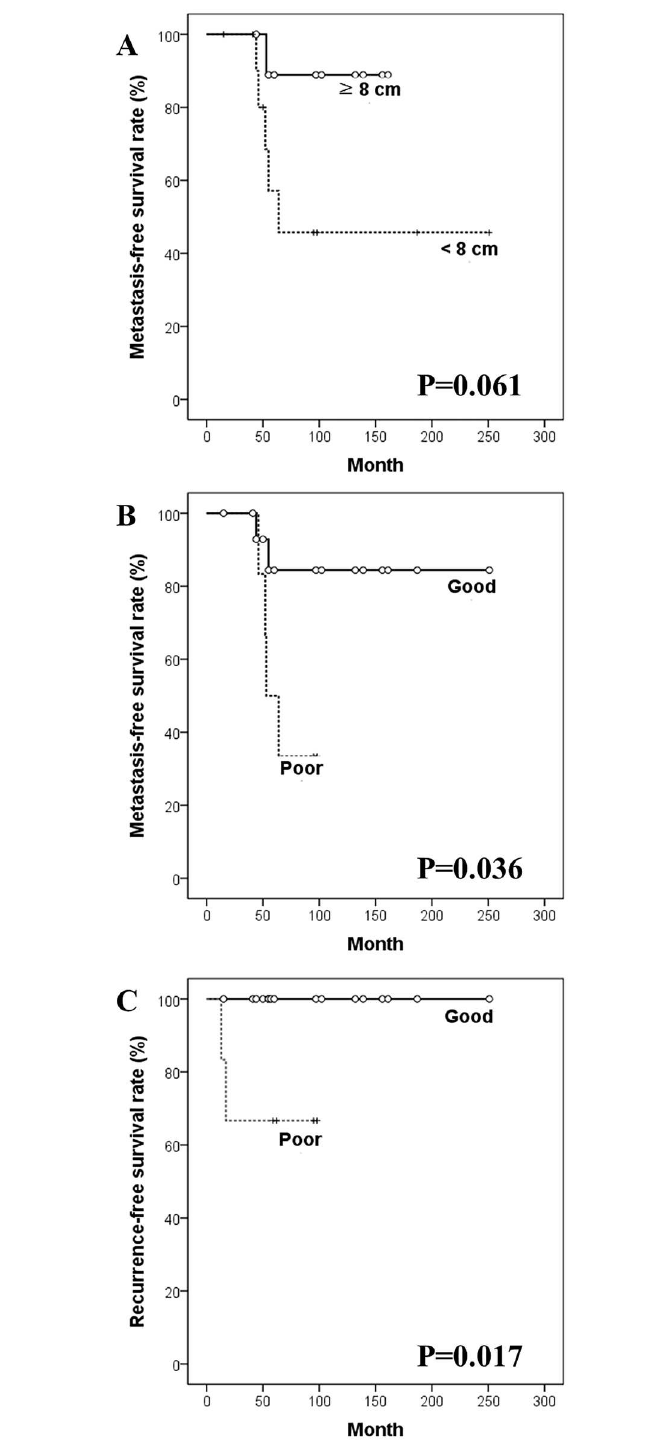
Fig 2. Kaplan-Meier survival curves in univariate analyses. Kaplan-Meier curves for metastasis-free survival accordingto (A) tumor size, and (B) histological responseto pre-operative chemotherapy, and for (C) recurrence-free survival accordingto histological